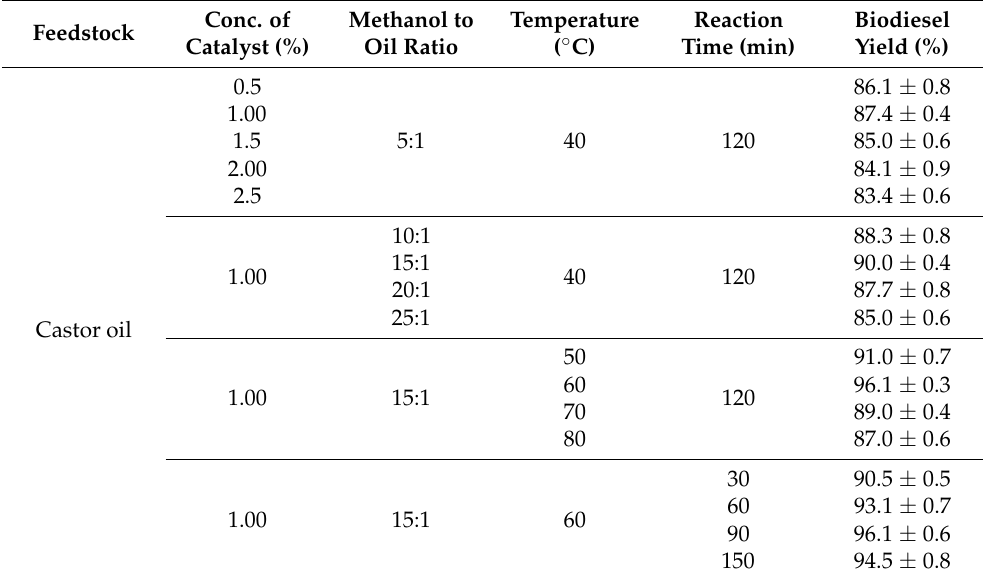
Table 7. Yield of biodiesel from castor oil with changes in reaction parameters. Feedstock